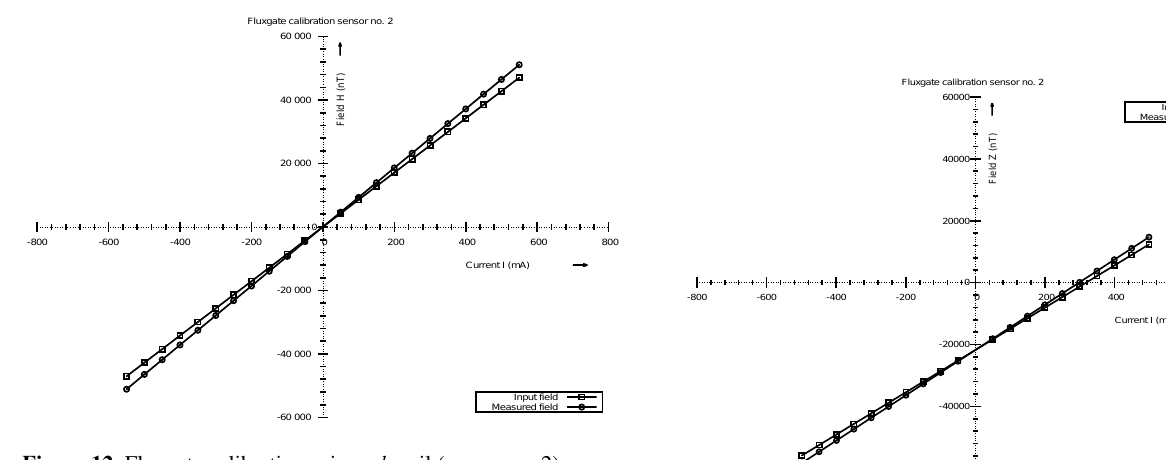
Figure 12. Fluxgate calibration using a h coil (sensor no. 2).